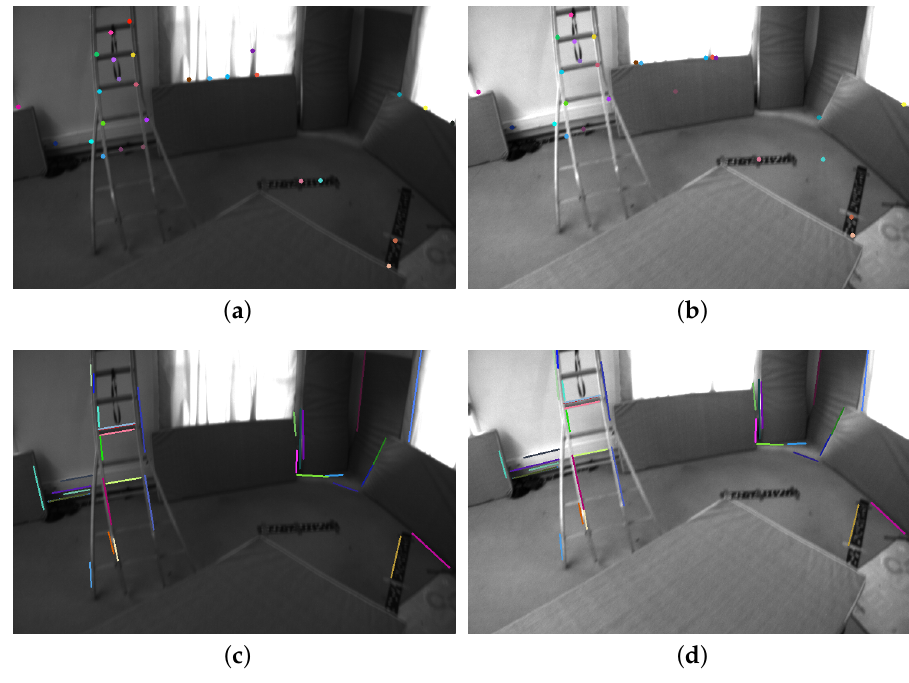
Figure 8. Tracked point/line features with rapid rotation in V1_03_difficult . Lighting conditions and view directions changed in successive frames. Matched point features are marked with the same color in frame ( a , b ). Matched line segment features are marked with the same color in frame ( c , d ).